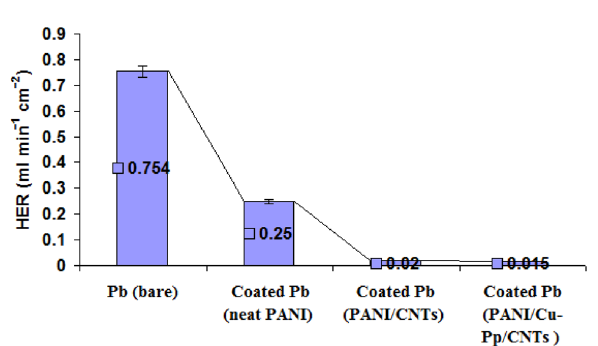
Figure 4. Hydrogen gas evolution (HER) for bare Pb, coated Pb (neat PANI), coated Pb (PANI/CNTs) and coated Pb (PANI/Cu-Pp/CNTs ) in 5.0 M H 2 SO 4 at 298 K.